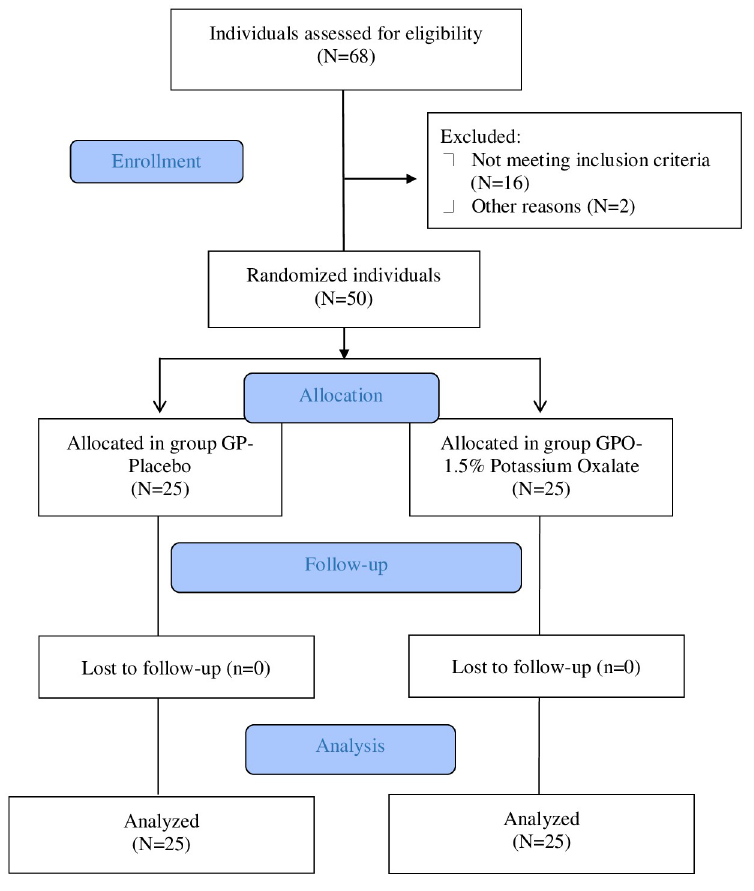
Fig 1. Study flow